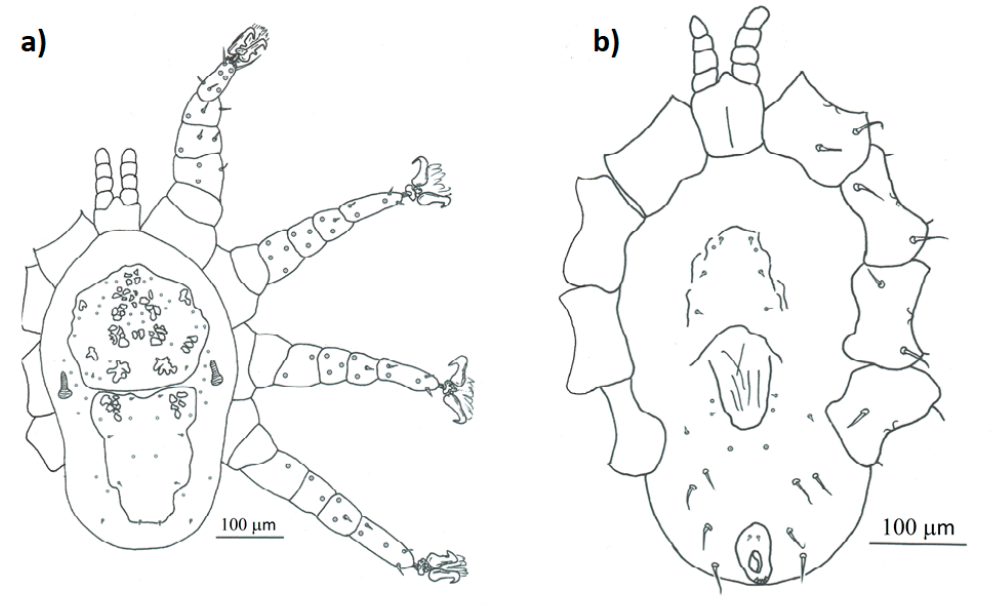
Figure 4. Detailed drawing of the morphological characteristics of female Mesonyssus columbae : ( a ) dorsal view; ( b ) ventral view.